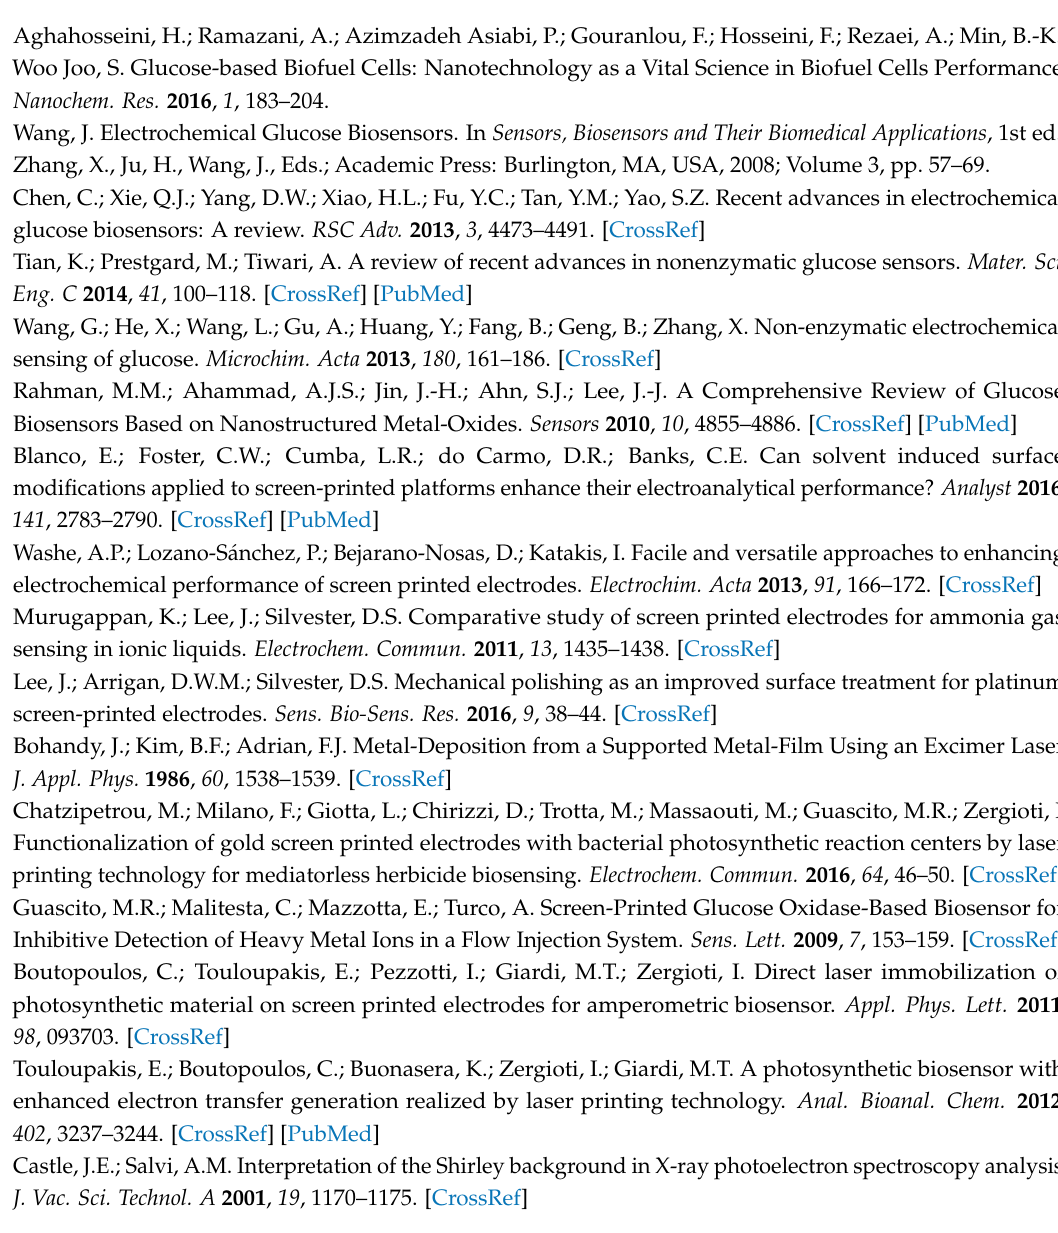
Figure S1: XPS high resolution region of C 1s and K 2p, Figure S2: XPS high resolution region of O